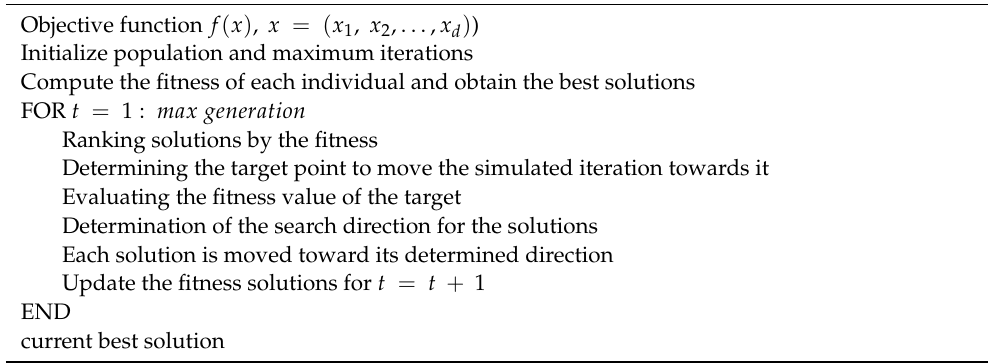
Algorithm 9: Weighted superposition attraction